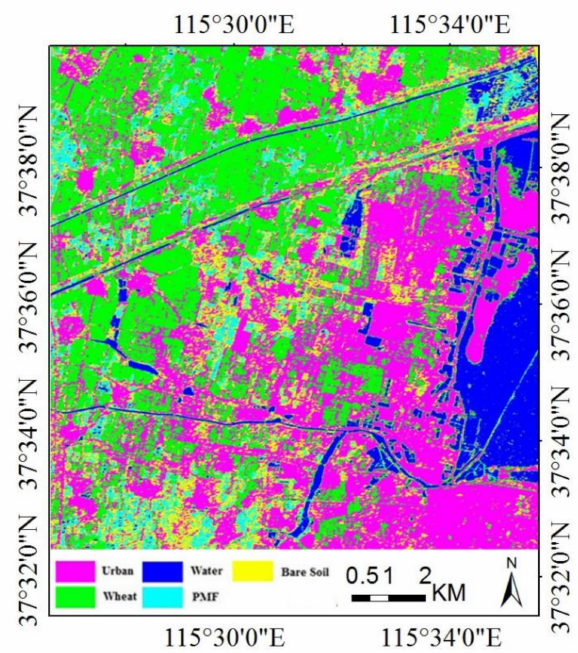
Figure 4. Classification map based on dual-polarimetric RADARSAT-2